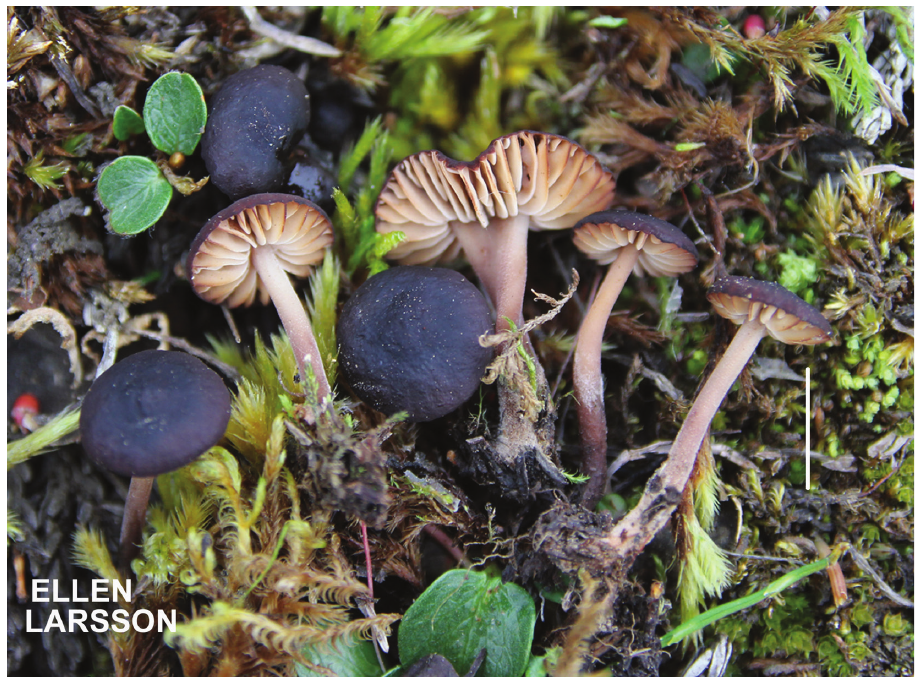
Figure 34. Mycetinis kallioneus . Basidiomata. Photo courtesy Ellen Larsson. ELS 57-17C. Standard bar = 20